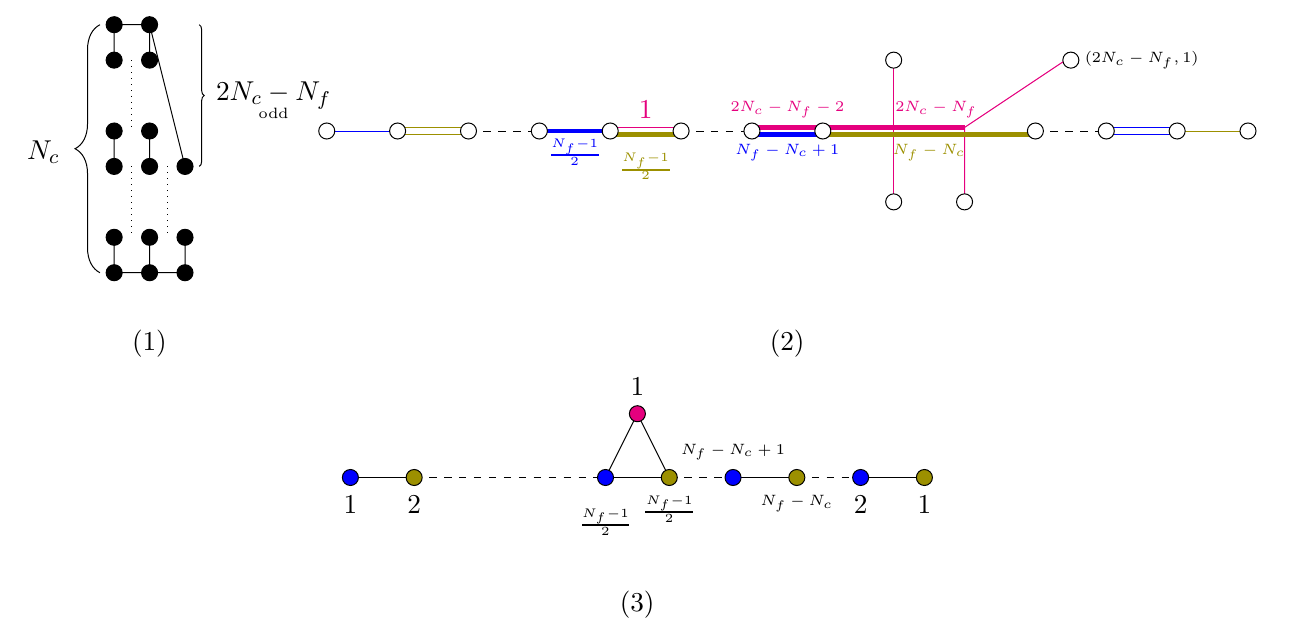
Figure 13 . (1) Toric Diagram representing SQCD with N c < N f < 2 N c 1, N f odd, at finite gauge coupling where masses are set to zero. (2) − Brane Web indicating the Mesonic cone of the Higgs Branch (3) magnetic Quiver whose 3d Coulomb Branch is the Mesonic cone of the Higgs Branch of our SQCD. It should be noted that the quiver is symmetric, however only the nodes visible in the brane web are